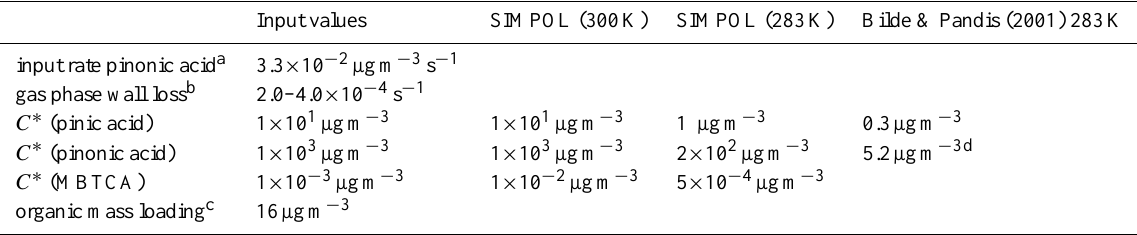
Table 1. Values for pinonic acid concentration